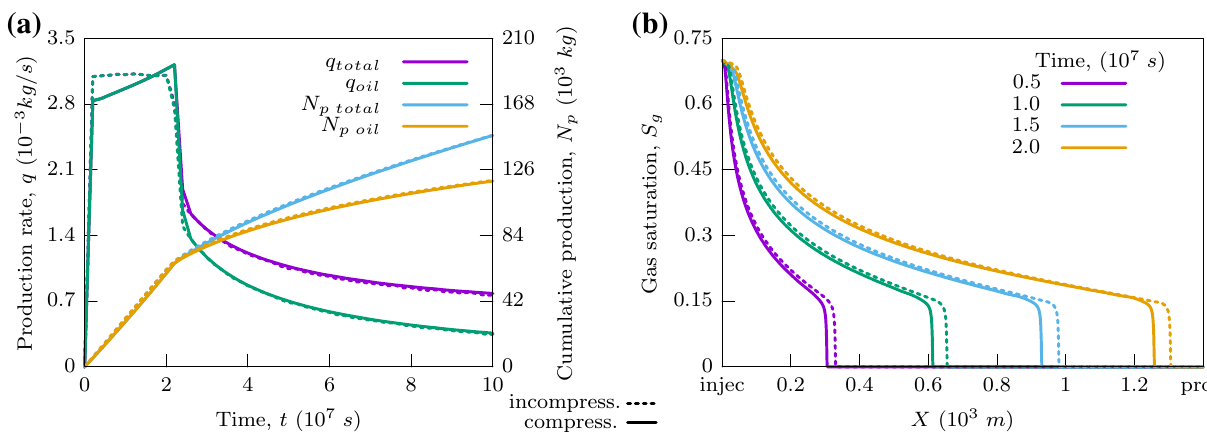
Fig. 4 Injectant gas CH 4 . 1D model. Scenario 2. Comparison of compressible and incompressible cases. a Production profiles. b Saturation pro-